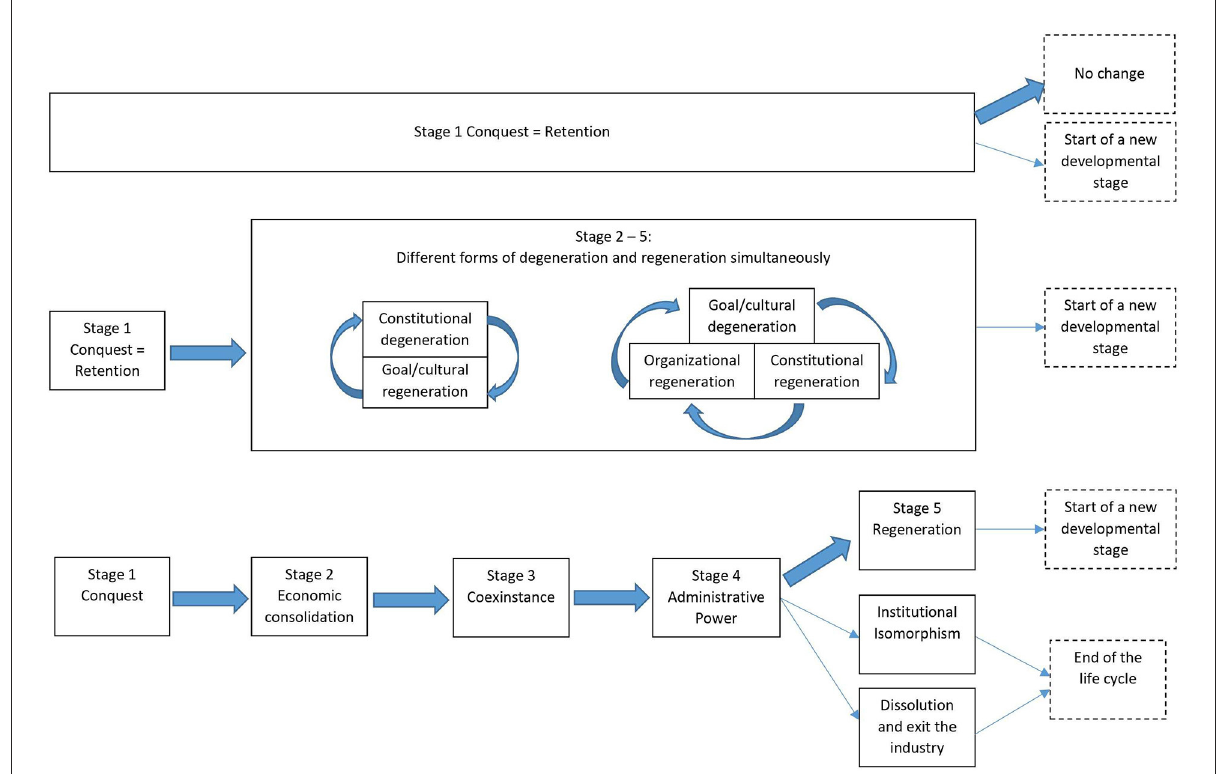
FIGURE2 Stages of the democratic enterprises’ life cycle (extension of Bretos et al., 2020’s life cycle